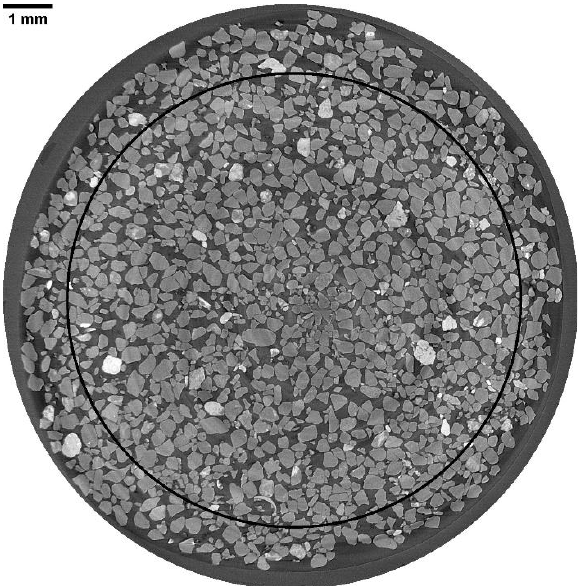
Figure 1. X-ray computed microtomography image showing a cross-section of one of the cores recovered at Alameda County beach. The black circle outlines the section of the image that we analyze. The outer grey ring is the plastic sampling